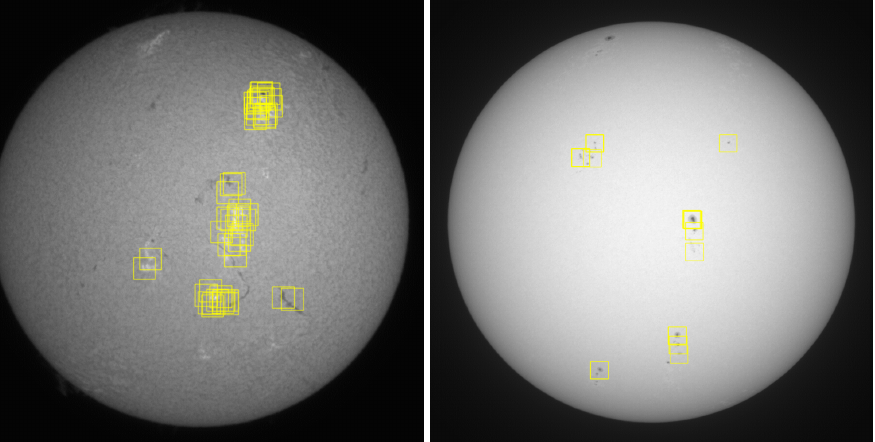
Figure 4. Sample solar disk in H-alpha ( left ) and in solar continuum ( right ) with marked selected regions in 50 consecutive runs of our pseudorandom patch selection